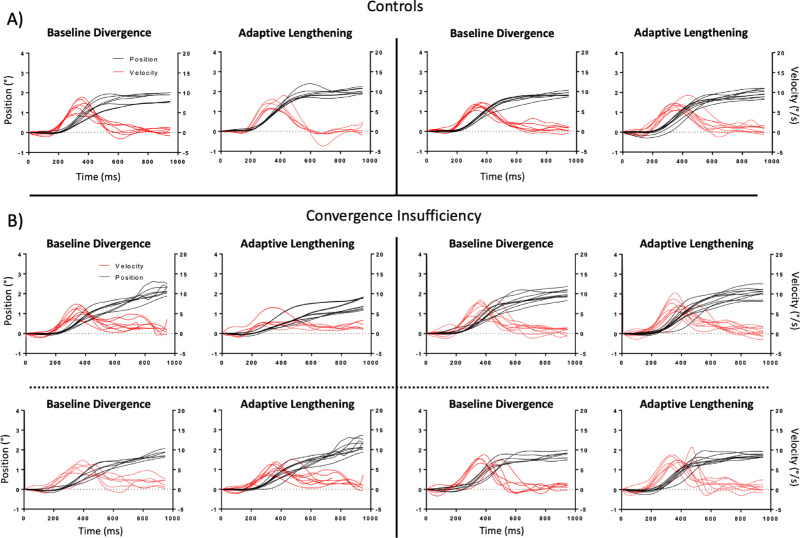
Divergence response amplitude (black) and velocity (red) traces for two BNC participants (A) and four CI participants (B). Baseline divergence plots are the saccade-free responses from the last block of the baseline phase. Adaptive lengthening plots are the vergence responses to the test stimuli during the adaptation phase. The subject plots at the top left in B show an example of one of the CI participants who was unable to fuse the divergence step stimuli during the latter portions of the adaptation phase.